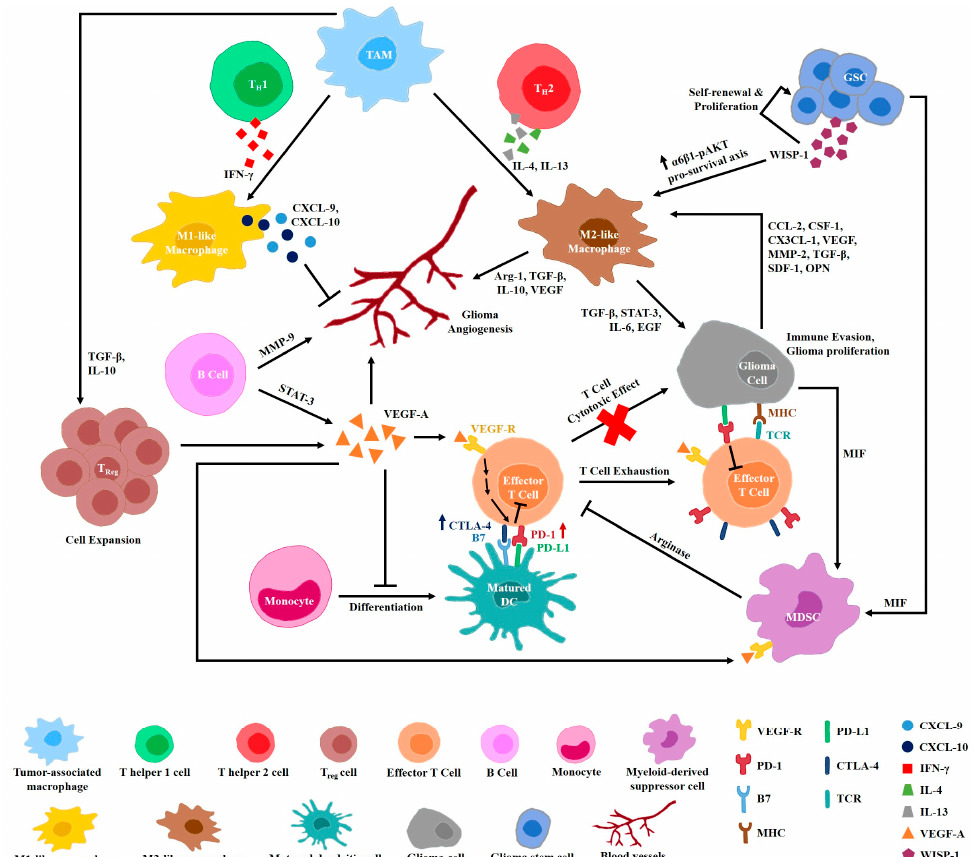
Figure 2. Crosstalk between immune cells and angiogenesis in glioblastoma. Glioma angiogenesis is the result of complex interactions with the immunosuppressive TME that consists of glioma cells, GSCs, and the various immune cells. M1-like and M2-like macrophages are polarized via T H 1-derived IFN- γ and T H 2-derived IL-4/IL-13, respectively, to mediate angiogenesis. The expansion of Treg releases VEGF-A to sustain tumor vessel growth. B cells modulate angiogenesis directly by producing STAT-3-dependent VEGF-A and MMP-9. VEGF signaling hinders DC maturation and its antigen presentation, suppresses effector T-cell functions via inhibitory immune checkpoint stimulation, and enhances MDSCs immunosuppressive activity, leading to glioma immune evasion. Macrophage migration inhibitory factor (MIF) secreted by GSCs and glioma cells acts on MDSCs-driven T-cell dysfunction. An M2-like TAMs phenotype can be further promoted by GSC-derived WISP-1 via the integrin α 6 β 1/pAKT axis. Crosstalk between glioma cells and M2-like TAMs via various chemokines and cytokines occurs to enhance immune suppression and angiogenesis, as well as tumor cell proliferation.